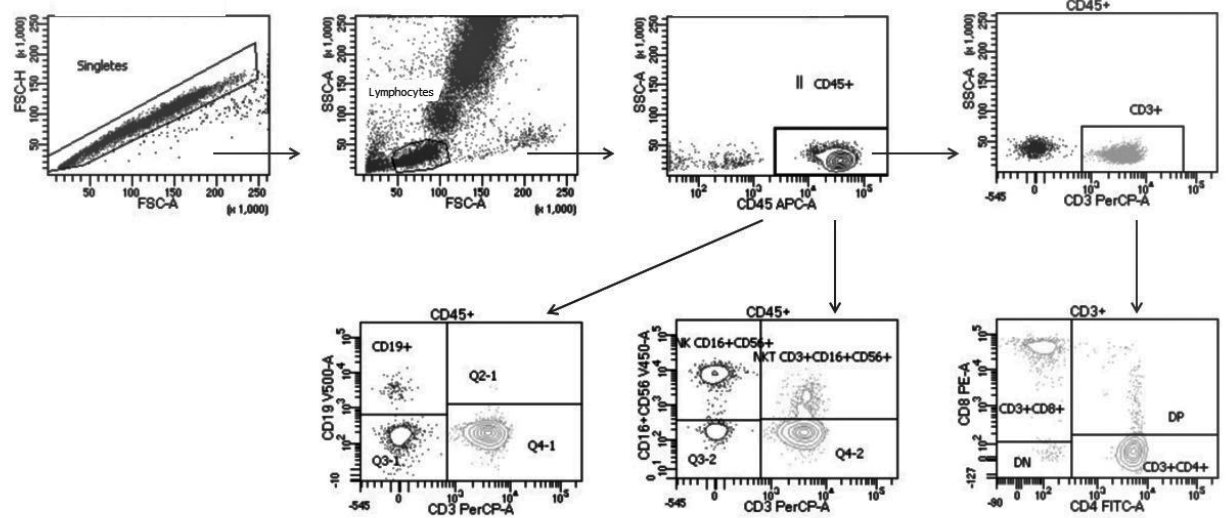
Figure 2. Flow cytometry strategy for analysis of lymphocyte subpopulations in study population. Gating strategy of flow cytometric analysis of lymphocyte subpopulations in patients with alcohol use disorder (AUD). Peripheral blood mononuclear cells (PBMCs) were stained with anti-CD45 APC, anti-CD19 V500, anti-CD3 PerCP, anti-CD4 fluorescein isothiocyanate (FITC), anti-CD8 PE, anti-CD16 V450, and anti-CD56 V450. Double lymphocytes were excluded. Single lymphocytes were gated based on their scatter characteristics or forward scatter height versus forward scatter area. Total lymphocytes and T cells were then obtained based on positivity for CD45 and CD3, respectively.